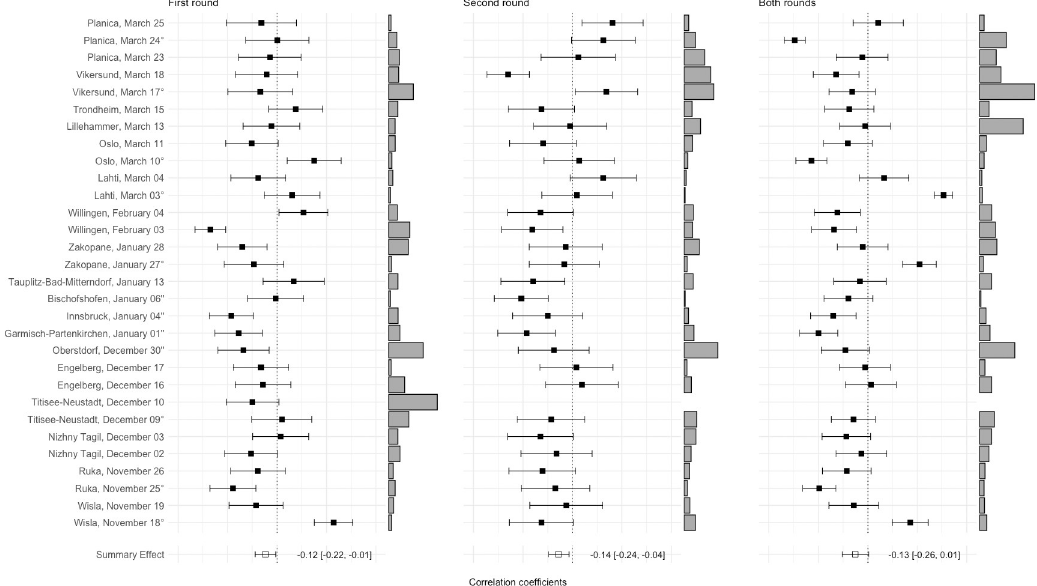
Fig 2. Forest plots of associations of wind points with round scores for first round, second round, and both rounds in the ski jumping season 2017/2018. Larger bars next to the effect sizes represent larger wind point variability and consequently less comparable wind conditions between competitors; for second round and both rounds results, no effect sizes are available for Titisee-Neustadt, December 10 due to cancellation of the second round;˚ = team competition; “= KO